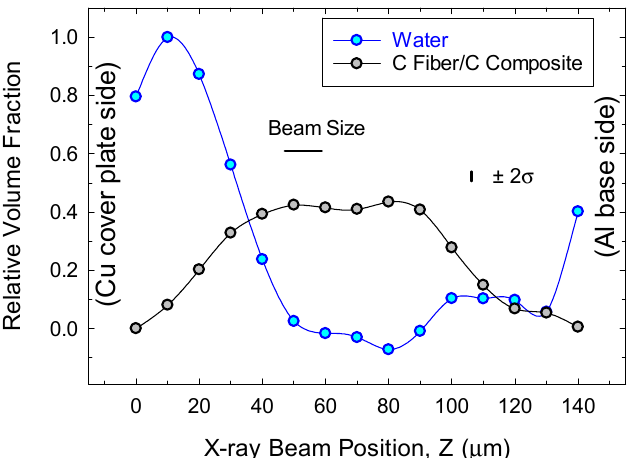
Figure 8. The depth dependency of the relative volume fraction of liquid water, together with that of the carbon fiber and carbon composite. the carbon fiber and carbon